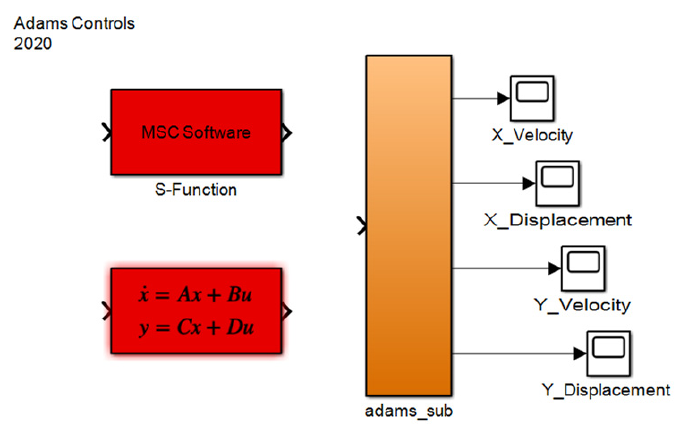
Figure 4. ADAMS output model.